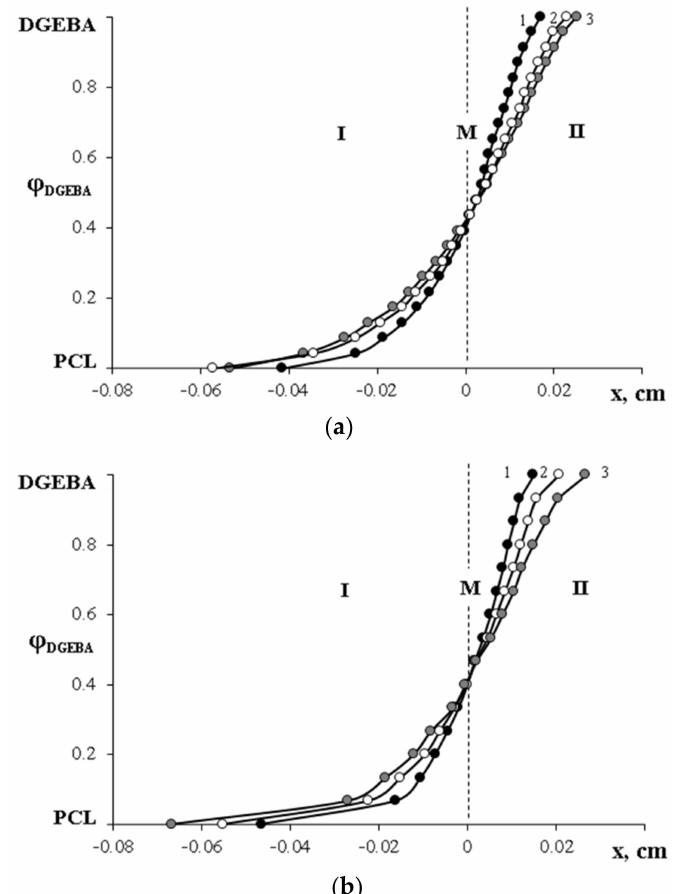
Figure 10. The concentration profiles of PCL–DGEBA systems at 80 ◦ C: ( a ) PCL with M n = 45 × 10 3 , where 1—16, 2—25 and 3—36 min; ( b ) PCL with M n = 80 × 10 3 , where 1—9, 2—16 and 3—25 min. M is the Matano–Boltzmann plane. I corresponds to the diffusion front of DGEBA in PCL, II corresponds to the diffusion front of PCL in DGEBA.